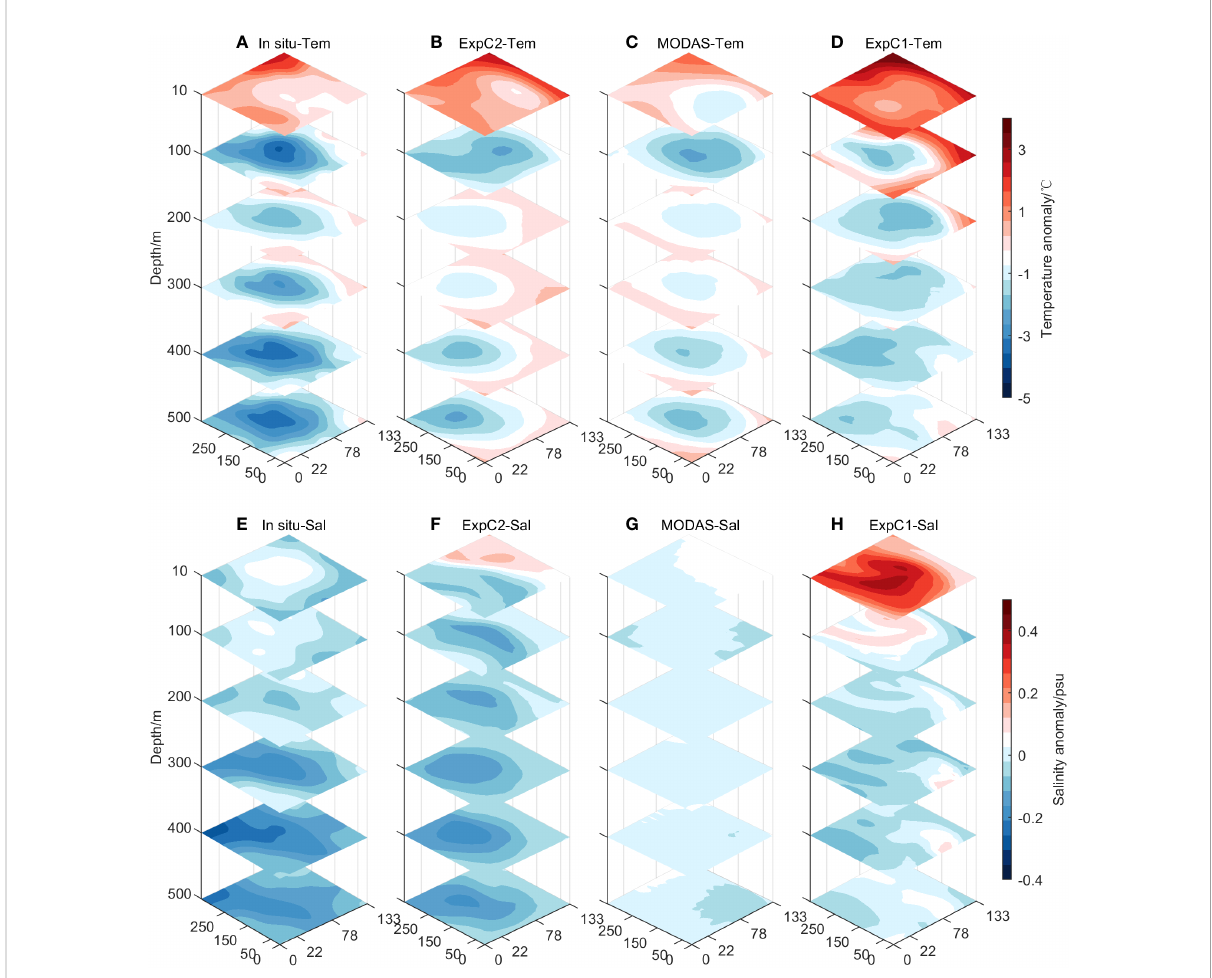
FIGURE 12 Temperature and salinity anomaly slices at 10m, 100m, 200m, 300m, 400m, and 500m. (A, E) the in-situ data, (B, F) the experiment results of assimilating the synthetic T/S pro fi les, (C, G) the MODAS data of the National Marine Data Center, and (D, H) the experiment results of the direct assimilation of satellite observations. The unit of abscissa and ordinate is